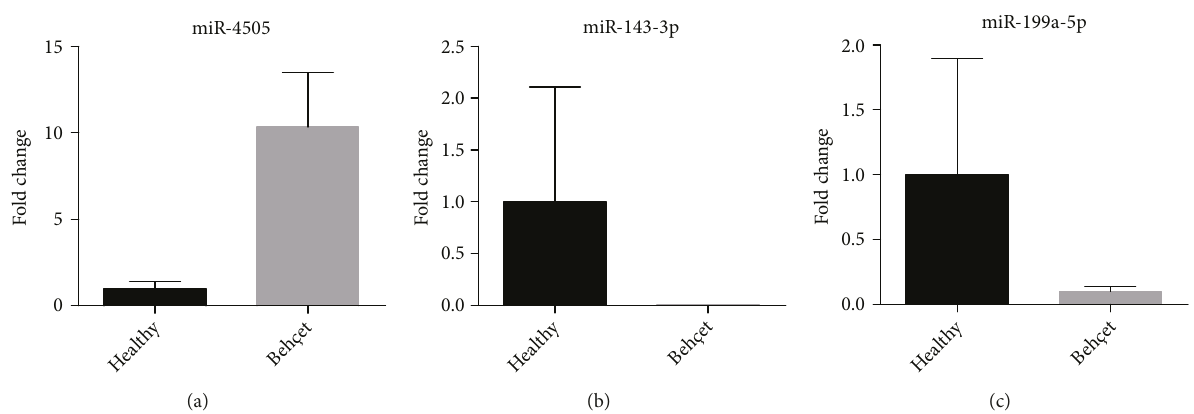
Figure 1: Validation of di ff erentially expressed miRNAs by real-time PCR. Real-time PCR for the indicated miRNAs were performed in healthy controls (Healthy) and in BD patients (Behçet). Values are calculated as fold change with respect to healthy samples with the ΔΔ Ct method. miR-16-5p and miR-26-5p were used as endogenous controls for miRNA expression (see Material and Methods). Histograms indicate mean values; bars indicate standard deviation (SD). p = 0 05 (Mann – Whitney